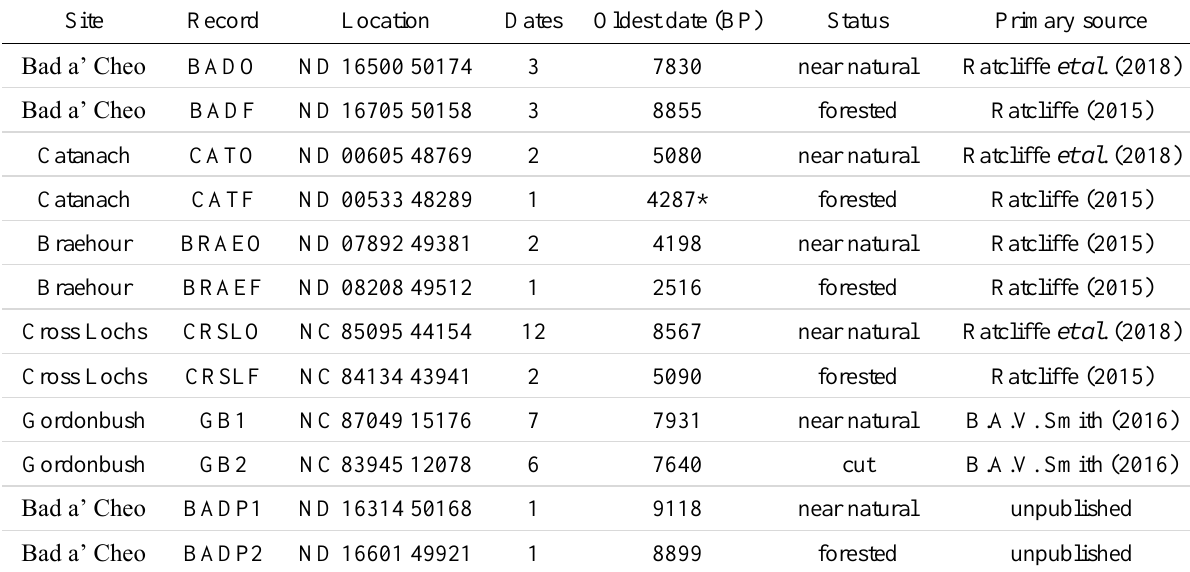
Table 4: New and re-analysed records of carbon accumulation including the location of the core, the number of dating points used (radiocarbon and tephra derived), the oldest date available (uncalibrated radiocarbon years), the disturbance status of the site (where near natural indicates no visible signs of disturbance), and the primary reference (where previously published). * indicates a calibrated age in BP, derived from the Hekla 4 eruption.